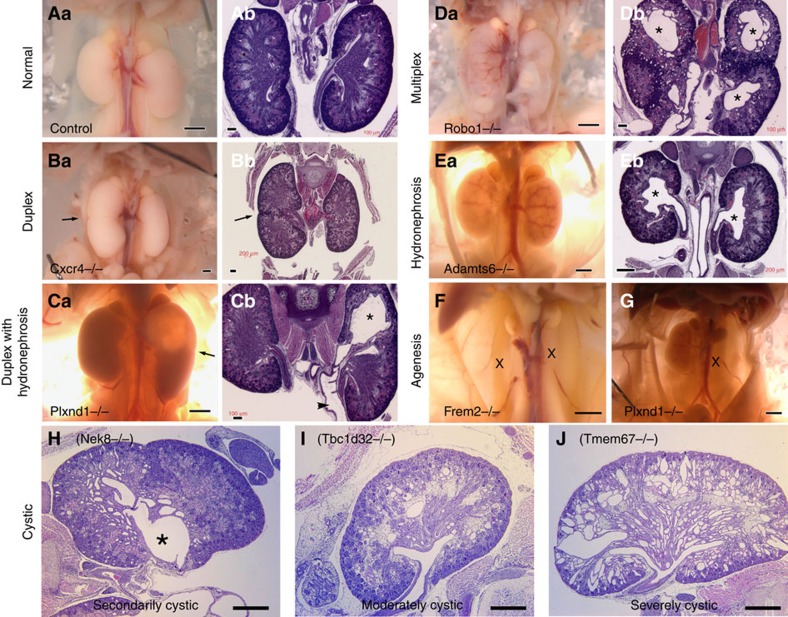
Phenotypes observed in screen.(A–G) Representative examples of the types of kidney defects observed. The a (left) image of most pairs is a necropsy image and the b (right) image is a haematoxylin and eosin (H&E)-stained image. Arrows point to the indentation that typically marks the junction between the two parts of a duplex kidney (Ba,Bb,Ca). Duplex kidney is thought to result from extra ureteric buds forming at the earliest steps of metanephric kidney development. The extra ureteric buds induce the formation of multiple (usually two) partial kidneys within a single capsule. If the second ureter does not properly drain, hydroureter (Cb, arrow head) and hydronephrosis (Cb,Eb*) can result. It is noteworthy that multiplex kidneys are similar to duplex kidneys, except that more than two kidneys are fused together on each side of the animal (Da,Db). The X marks the position of the missing kidneys in the agenesis images (F,G). Scale bars, 1 mm (Aa,Ba,Ca,Da,Ea,F,G). Scale bars, 100 μm (Ab,Cb,Db) and 200 μm (Bb,Eb). (H–J) Bottom row shows examples of the different types of cystic kidney disease identified in the ENU screen. It is noteworthy that the Nek8 kidney is duplex and only the hydronephrotic (*) half of the kidney is cystic. This indicates that the cysts are secondary to the hydronephrosis. Moderate cystic disease was defined as a few large cysts accompanied by smaller dilations in the other tubes, while severe cystic disease was defined by having large cysts throughout the kidney. Scale bars, 500 μm (H–J).